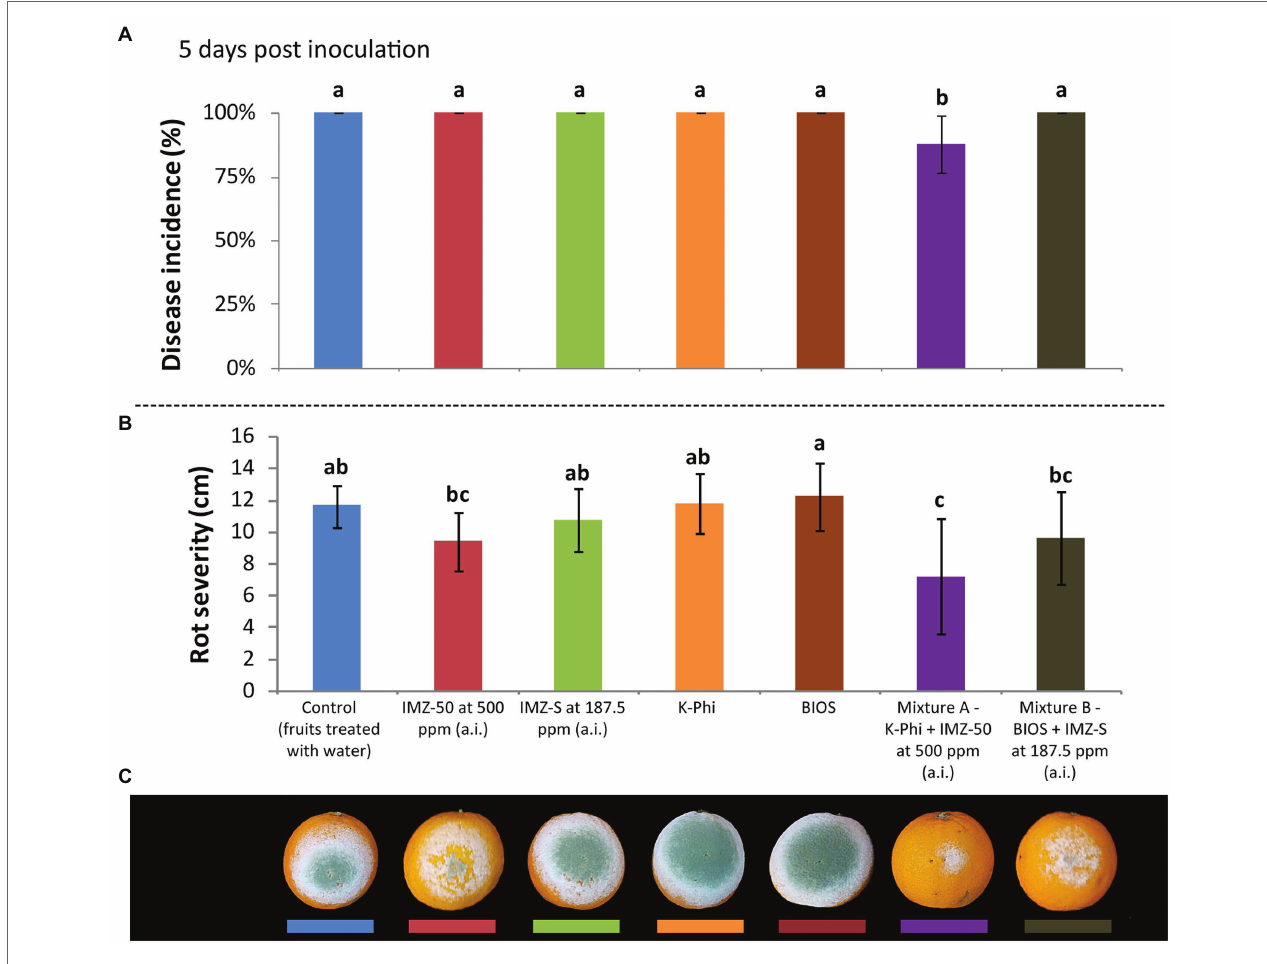
FIGURE 4 | Evaluation of the induced resistance as (A) disease incidence (%) and (B) rot severity (cm), as well as observed symptoms of decay in fruits (C) , caused by Penicillium digitatum strain, P_digit_G.B.A., in Citrus sinensis cv. Moro nucellare orange fruits treated with water (control) or IMZ-50 (emulsifiable concentrate formula at 50% w/v of active ingredient - a.i.) at 500 ppm a.i., IMZ-S (formula at 7.5% w/v of a.i.) at 187.5 ppm a.i., K-Phi formula (57% w/v) at the dosage of 0.25%, BIOS formula at the dosage of 0.15%, Mixture A (K-Phi: 0.25%; IMZ-50: 500 ppm a.i.), and Mixture B (BIOS: 0.15%; IMZ-S: 187.5 ppm a.i.)